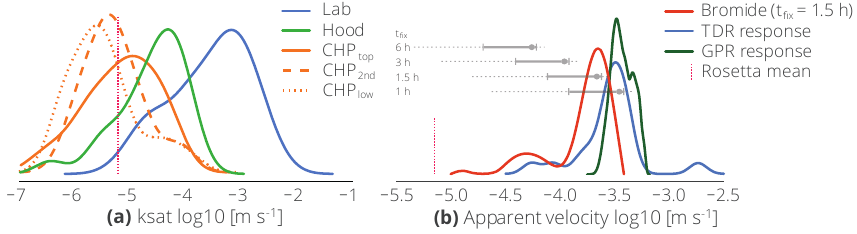
Figure 9. Saturated hydraulic conductivity and apparent vertical flow velocity kernel density estimates. (a) Point-scale measurement results (Lab: Ksat apparatus; Hood: Hood Tension-Infiltrometer; CHP: Constant Head Permeameter in different depth levels); (b) results from plot- scale irrigation experiments. Vertical gray lines are box plots of velocity distribution based on different t fix estimates for bromide. Rosetta (Schaap et al., 2001) reference based on mean values of ring samples (15.7, 47.9, 36.4% sand, silt, clay and BD 1.1gcm − 3